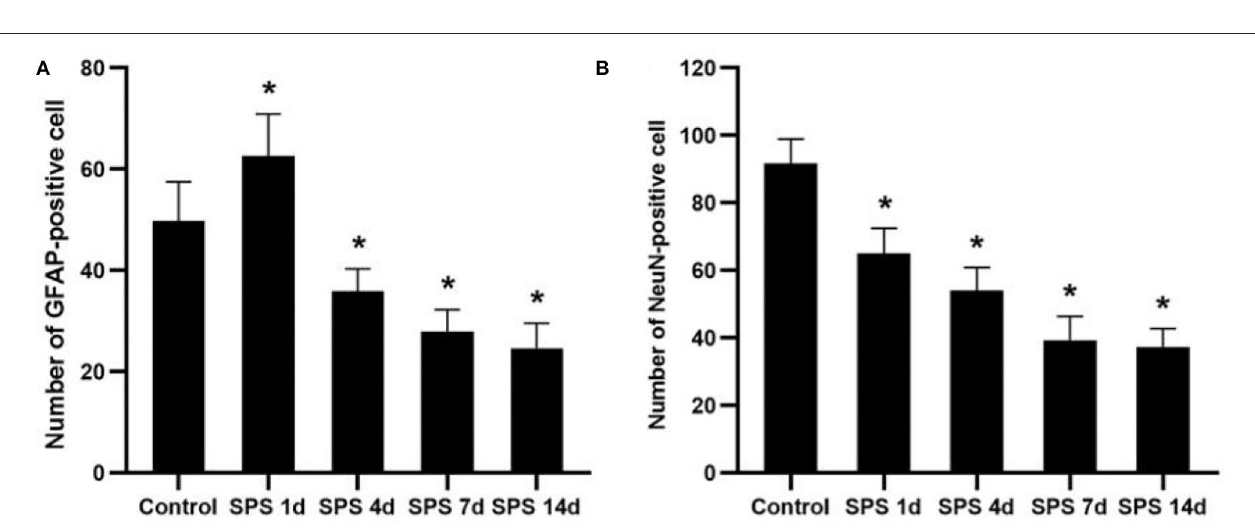
FIGURE 8 | Immunofluorescence observation of NeuN in mPFC. Representative images of NeuN-IR and results analysis in mPFC (magnification × 400, Bar = 20 µ m): (A) control group; (B) SPS 1d; (C) SPS 4d; (D) SPS 7d; (E) SPS 14d. (F) Quantity analysis of NeuN-IR expression in mPFC in each group. * P < 0.05 vs. control group.